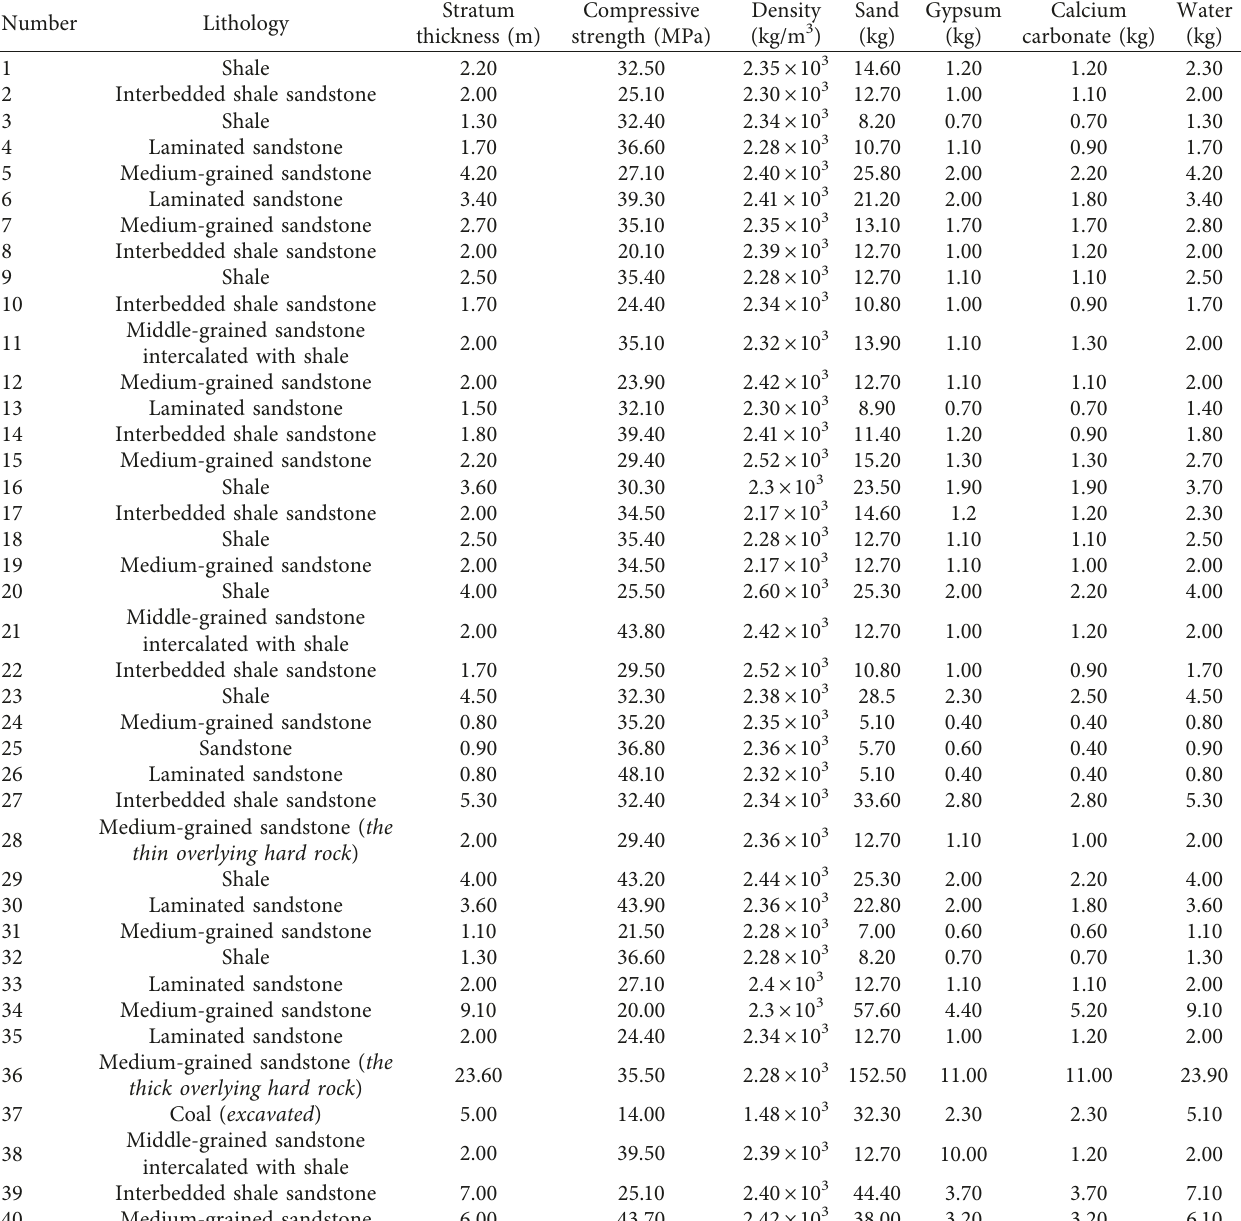
Table 1: Parameters of coal rock materials and the similar material simulation